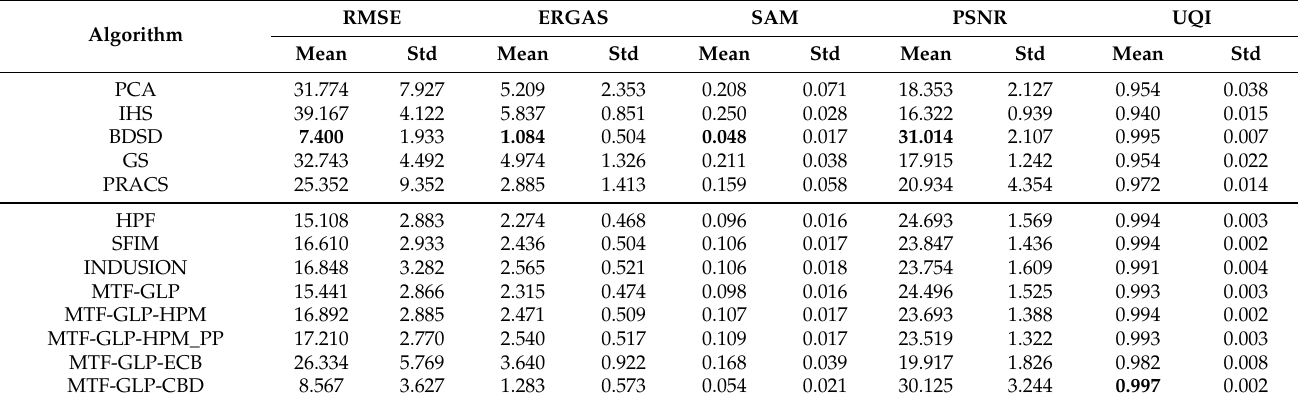
Table 4. Quality indices for the Grayscale Thermal Pansharpened images of the Illescas UAV dataset for each pansharpening algorithm